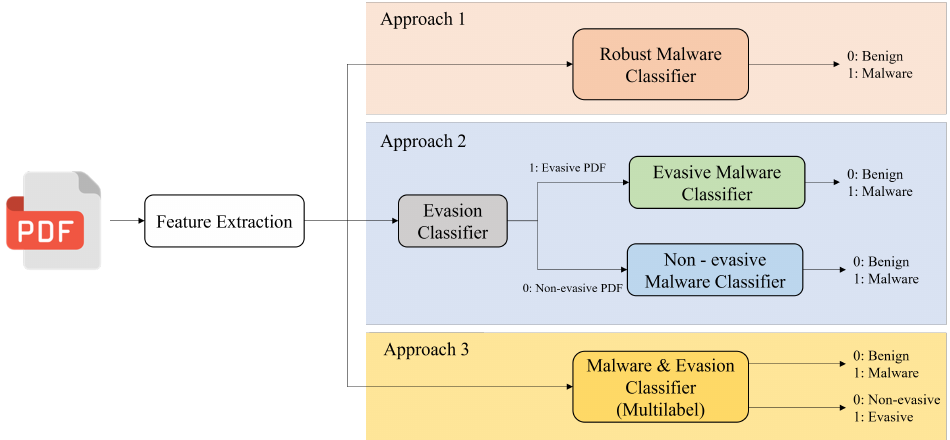
Figure 1. Building blocks of the three proposed